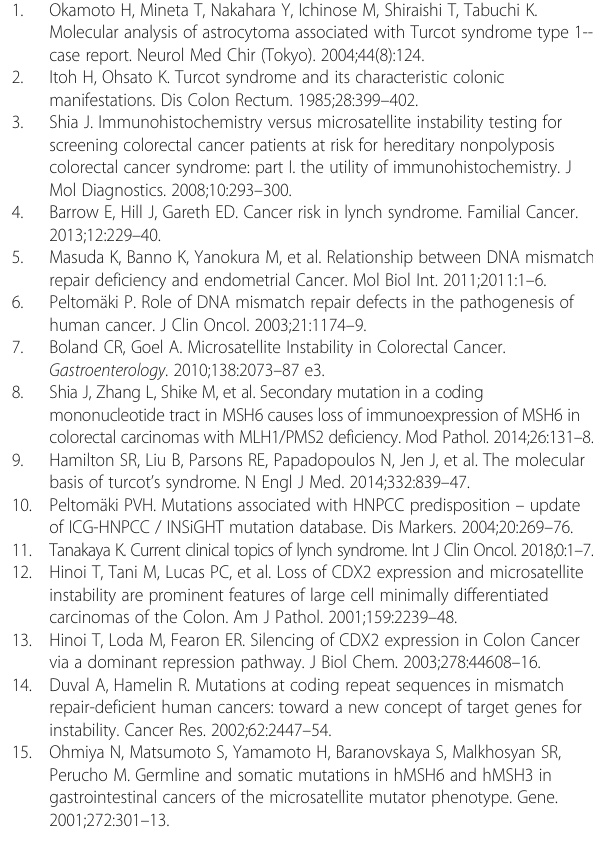
Additional file 1: Figure S1. Electropherograms of the cloned PCR products from liver metastasis; the wild-type sequence (a); deletion of 1 C, − 1wt (b); insertion of 1 C, wt + 1 (c). Additional file 2: Figure S2. Histological examination and immunohistochemical staining for mismatch repair proteins of this patient ’ s brain tumors, at the age of 39 (a) and 46 (b) HE staining of the brain tumors showed anaplastic astrocytoma. The tumors showed intact staining for the MMR